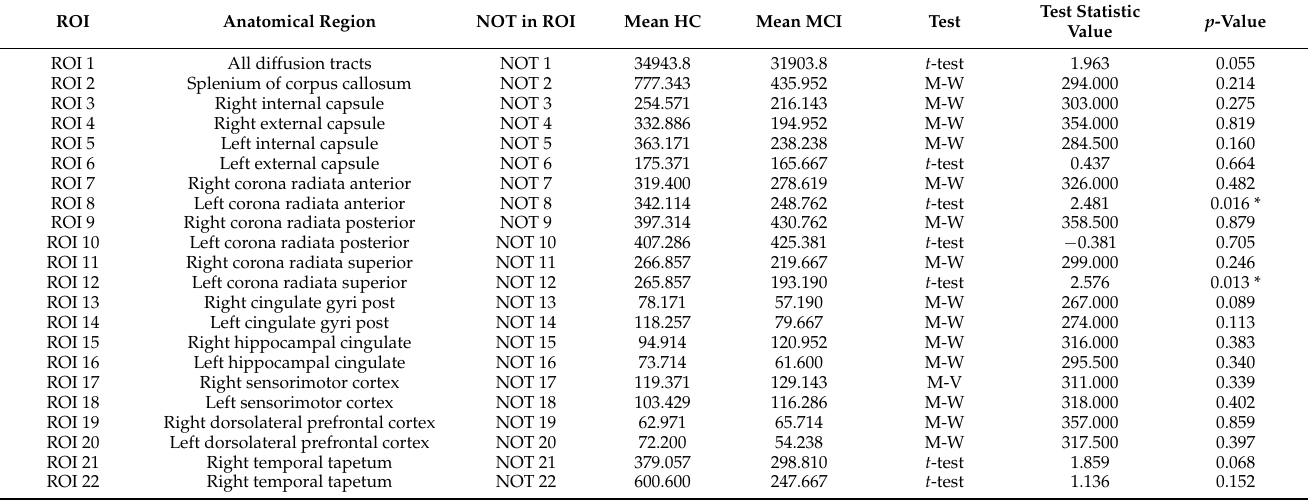
Table 3. Group differences in the number of tracts (NOT) in different regions of interest (ROIs) obtained for older healthy controls (HC) and older adults with mild cognitive impairment